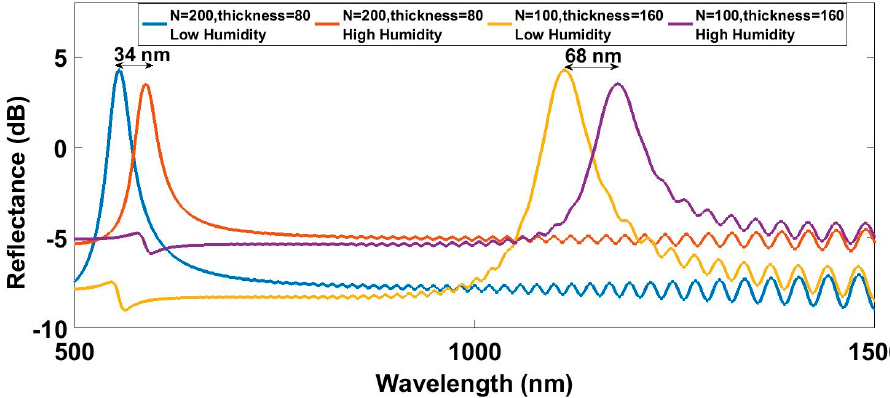
Figure 3. Simulated reflected spectra for extreme RH values with different number of periods but equal overall thickness.